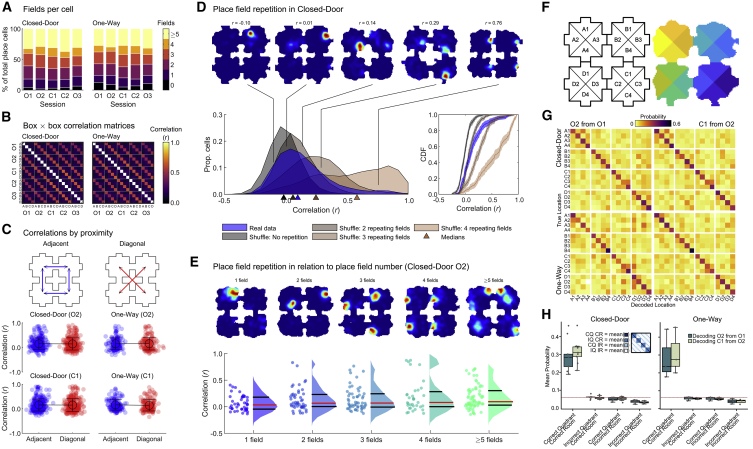
Most place cells encode global position in the four-room maze(A) Percentage of place cells grouped by number of detected place fields.(B) Cross-box correlation matrices averaged over all place cells.(C) Paired rate map correlations between adjacent or diagonal boxes.(D) (D) and (E) show data for O2, Closed-Door sequences. Shown on top, example rate maps (all data) with corresponding correlation values from the data distribution (blue). On the bottom left, the blue distribution represents cross-box correlation values for session O2. Other distributions represent shuffles simulating the correlations expected for different field repetitions. x axis markers indicate the distribution medians. On the bottom right, the same data is presented as empirical cumulative distribution functions; shaded areas represent lower and upper confidence intervals.(E) Top, example rate maps for each place field category. Shown on the bottom, cross-box correlations scores for all data, separated by number of fields; dots correspond to individual place cells, and data distributions are shown as violin plots with median in red and quartiles in black.(F) Box quadrants used for Bayesian decoding with example binned position data.(G) Mean confusion matrices from sequences with at least 15 simultaneously recorded place cells from Closed-Door (n = 9) and One-Way (n = 3) sequences; see Figure S7.(H) Average decoding performance for different categories (see inset). Points indicate session-average probabilities per quadrant for each category. Red line indicates chance performance (1/16 quadrants).See also Figures S6 and S7.